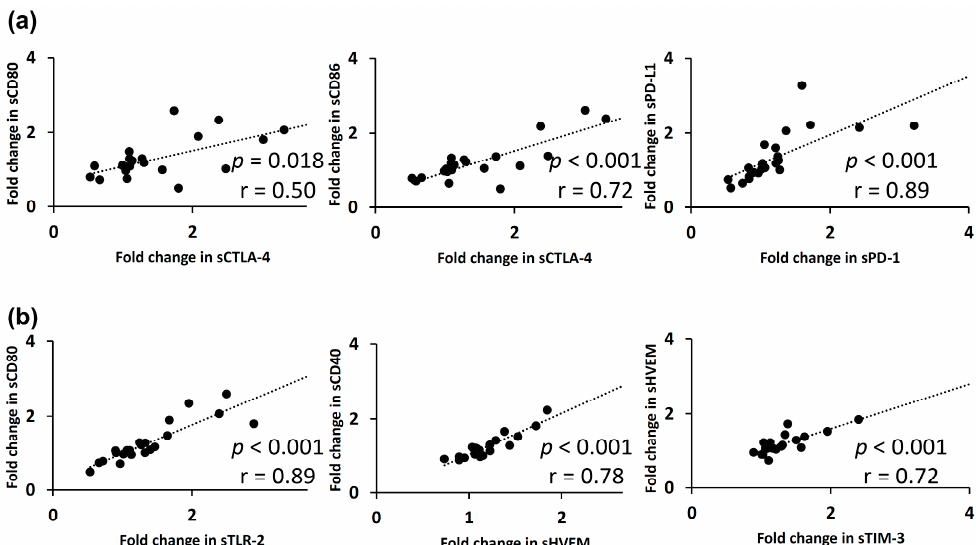
Figure 5. The relationships between fold-changes in soluble immune checkpoint protein levels in plasma at 1 week of receiving TACE are shown. ( a ) A positive correlation was found between the fold-changes of soluble checkpoint receptors and their ligands, including sCTLA-4 with sCD80 / sCD86 and sPD-1 with sPD-L1. ( b ) Separately, a strong correlation was observed between the fold-changes in sCD80 and sTLR-2 levels, sCD40 and sHVEM levels, and sHVEM and sTIM-3 levels. Spearman’s rank correlation test was used. A p -value of less than 0.05 was considered to be statistically